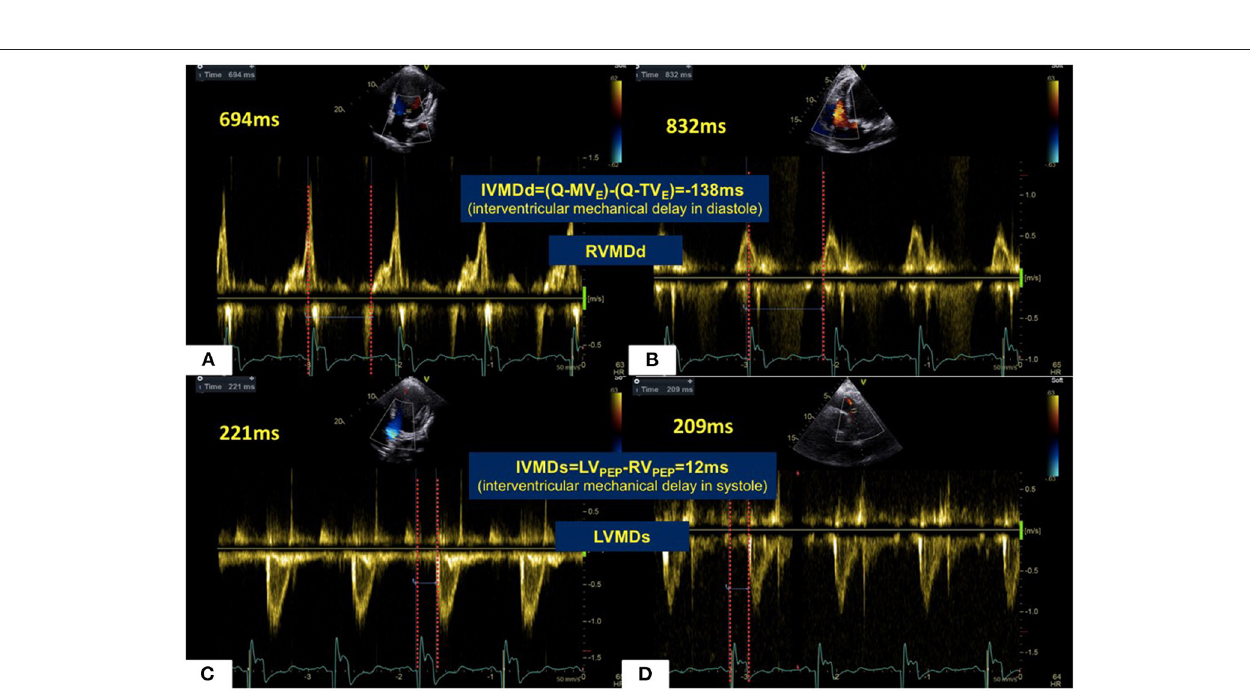
FIGURE 3 | Mechanical sequences between LV and RV in a patient with HF. In diastole (A,B) , LV filling occurred 138ms prior to RV filling giving a RVMDd pattern. This was in marked contrast to most healthy subjects. For systolic ejection (C,D) , RV ejection preceded LV ejection by 12ms in a LVMDs pattern. Abbreviations as in legend to Figure 1